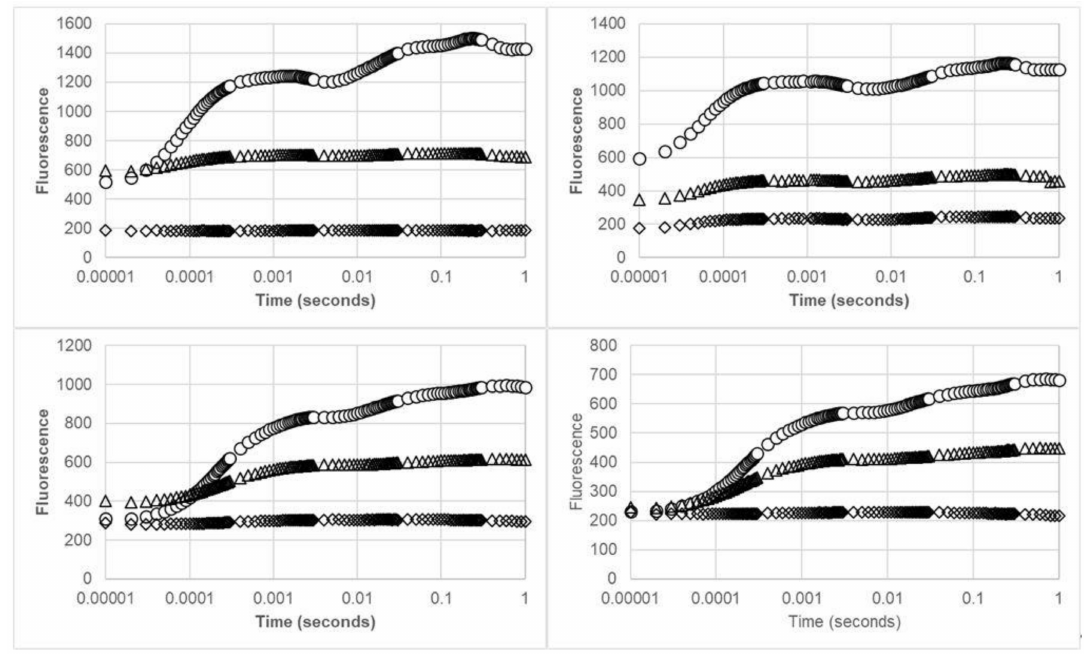
Figure 1. OJIP fluorescence transients of the lichen Evernia prunastri (up) and the moss Brachythecium sp. (down) after the O 3 fumigation (left) and the recovery time (right). Legend: ( (mean of dry and wet), ( ∆ ) dry fumigated samples, ( ♦ ) wet fumigated